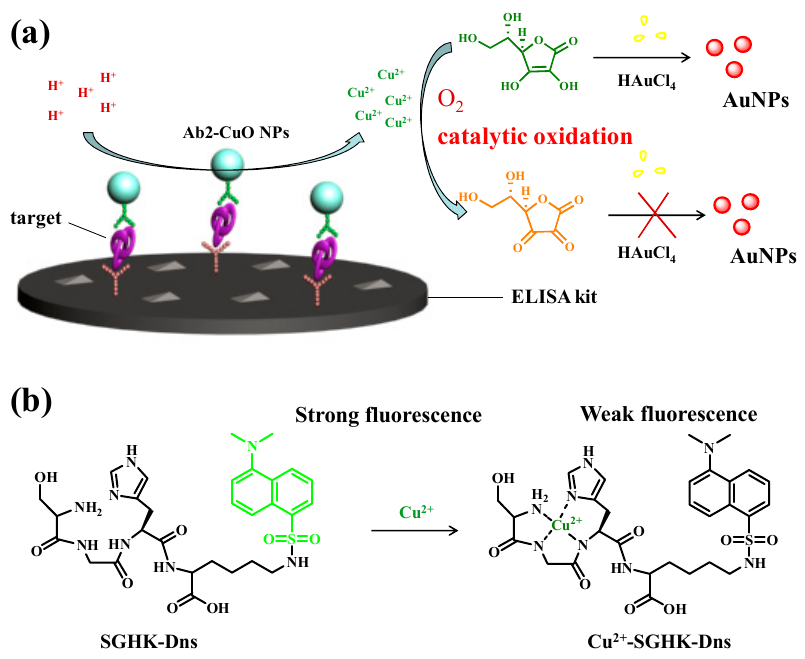
Figure 1. ( a ) Schematic representation of the immunosensor with CuO nanoparticle (CuO NP) labels based on the Cu 2+ -catalyzed ascorbic acid (AA) oxidation and in situ growth of AuNPs; ( b ) Fluorescence detection of the released Cu 2+ with the probe of SGHK-Dns.